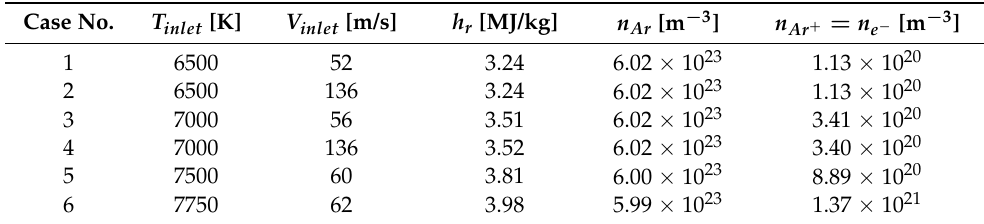
Table 2. Test parameters considered in this study. Densities and flow rates determined from the test conditions provided in Table